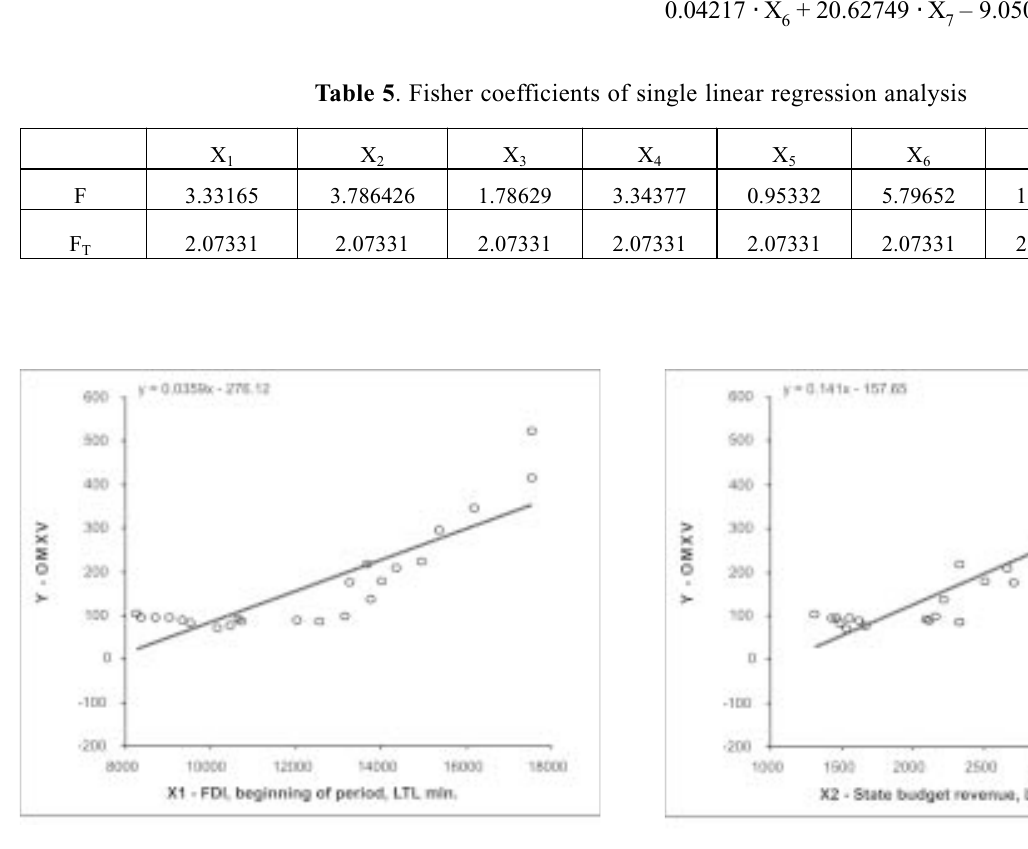
Fig 1. Dependence of OMXV index on FDI (mill. Lt)